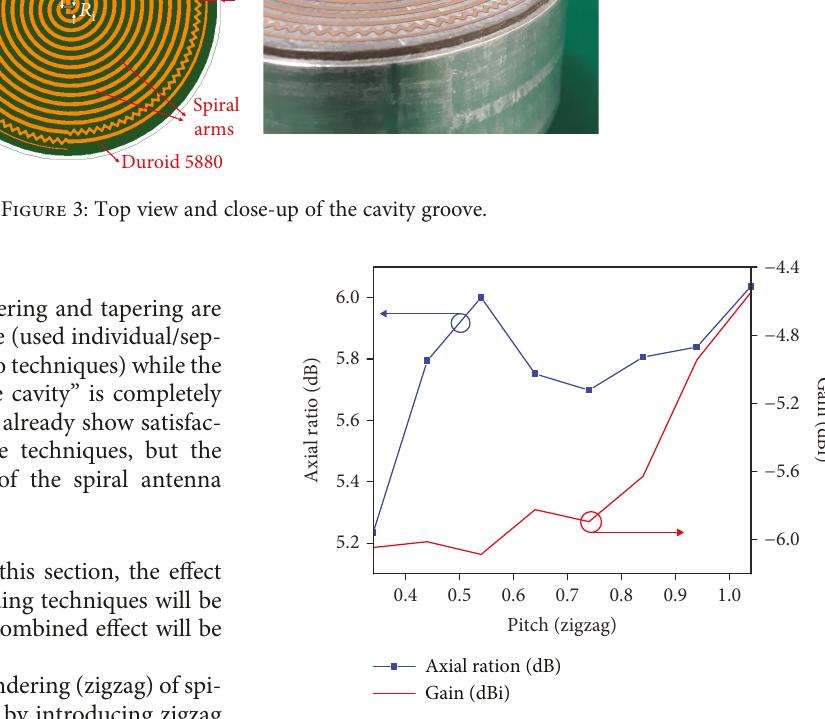
Figure 4: Trend of gain and axial ratio with